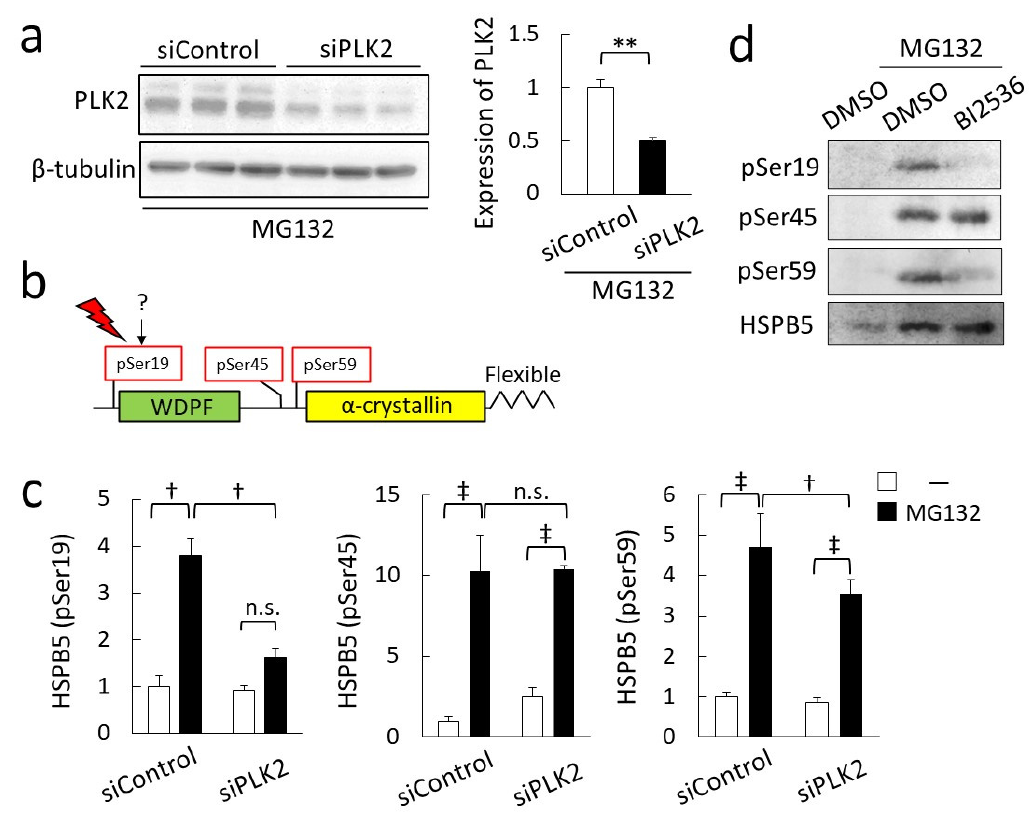
Figure 5. PLK2 phosphorylates HSPB5 at serine 19 under ER stress. ( a ) Knockdown efficiency of PLK2 by siRNA. L6 cells were transfected with siRNA to knockdown PLK2 and treated with 5 µ M MG132 for 24 h. Graph presents relative value of expression level of PLK2. Data in graphs represent means ± standard error (n = 3). Statistical analyses were performed using t -test. ** p < 0.01. ( b ) Schematic representation of three known phosphorylation sites of HSPB5. Arrows indicate name of the kinase catalyzing phosphorylation. ( c ) Effect of PLK2 on each phosphorylation site. Undifferentiated L6 cells were transfected with siRNA to knockdown PLK2. After differentiation (48 h), L6 myotubes were treated with 5 µ M MG132 for 24 h. Phosphorylation level was detected by Western blotting with specific antibodies. Graph presents ratio of phosphorylated HSPB5/HSPB5 after quantification of each band. Data in graphs represent means ± standard error (n = 3). Statistical analyses were performed using one-way ANOVA with Tukey test. ‡ p < 0.01, † p < 0.05; n.s. not significant. ( d ) Effect of PLK2 activity on phosphorylation of serine 19. After differentiation (48 h), L6 myotubes were treated with 10 nM BI2536 and 5 µ M MG132 for 24 h. Phosphorylation level was detected by Western blotting with specific